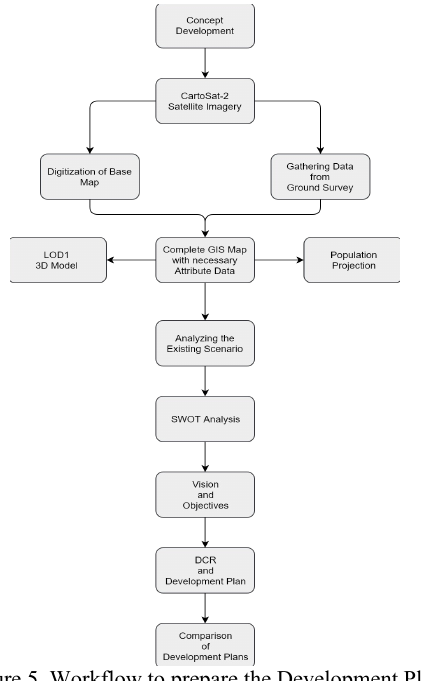
Figure 5. Workflow to prepare the Development Plan